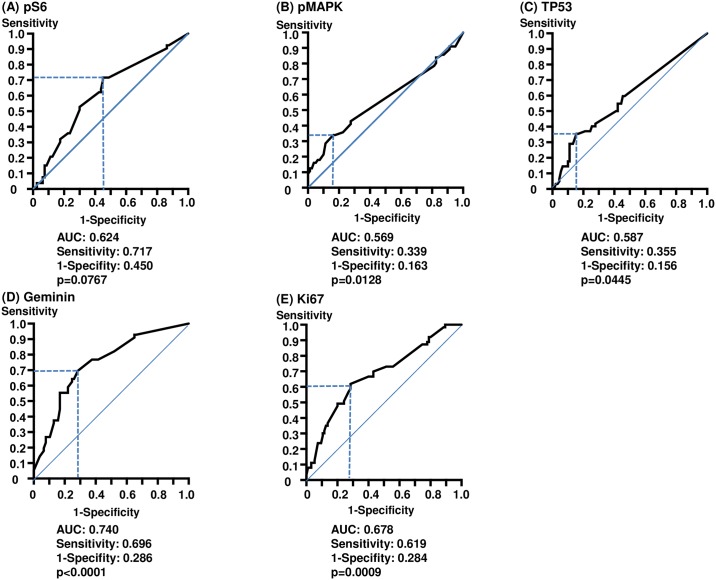
Receiver operating characteristics curves of pS6, pMAPK, TP53, geminin and Ki67 for SUVmax.The cutoff values were determined as 10% for pS6 (A), 20% for pMAPK (B), 20% for TP53 (C), 4% for geminin (D) and 21.5% for Ki67 (E).